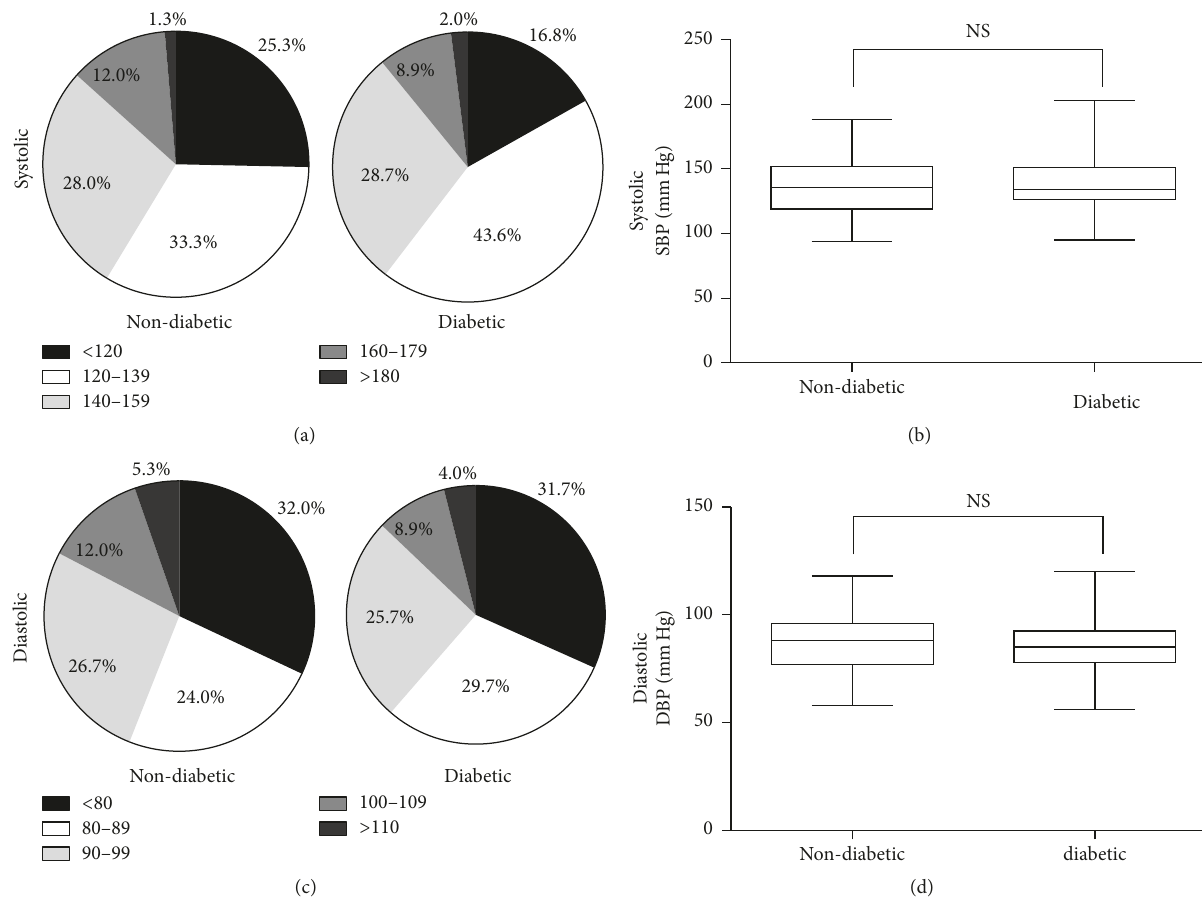
Figure 2: Blood pressure measurements. (a) Systolic blood pressure distribution in nondiabetic and diabetic groups showing the proportion of normal BP (80 mm Hg ≤ SBP < 119mm Hg), prehypertension (120mm Hg ≤ SBP ≤ 139mm Hg), hypertension stage 1 (140mm Hg ≤ SBP ≤ 159mm Hg), and hypertension stage 2 (SBP ≤ 160 mm Hg) in nondiabetic (𝑛 = 69) and diabetic (𝑛 = 85) groups. (b) Box plot of systolic blood pressure for nondiabetic and diabetic groups. The upper and lower whiskers indicate the maximum and minimum values, respectively. The upper and lower borders of the box indicate the 25th and the 75th percentile, respectively, while the black line in each box indicates the median. (c) Diastolic blood pressure distribution in nondiabetic and diabetic groups showing the proportion of normal BP (60mm Hg < DBP < 79 mm Hg), hypertension (80 mm Hg < DBP < 89 mm Hg), hypertension stage 1 (90mm Hg ≤ DBP ≤ 99 mm Hg), and hypertension stage 2 (DBP ≤ 100mm Hg). (d) Box plot of diastolic blood pressure for nondiabetic and diabetic groups. The upper and lower whiskers indicate the maximum and minimum values, respectively. The upper and lower borders of the box indicate the 25th and the 75th percentile, respectively. The black line in each box indicates the median. SBP: systolic blood pressure. DBP: diastolic blood pressure. NS indicates no significant